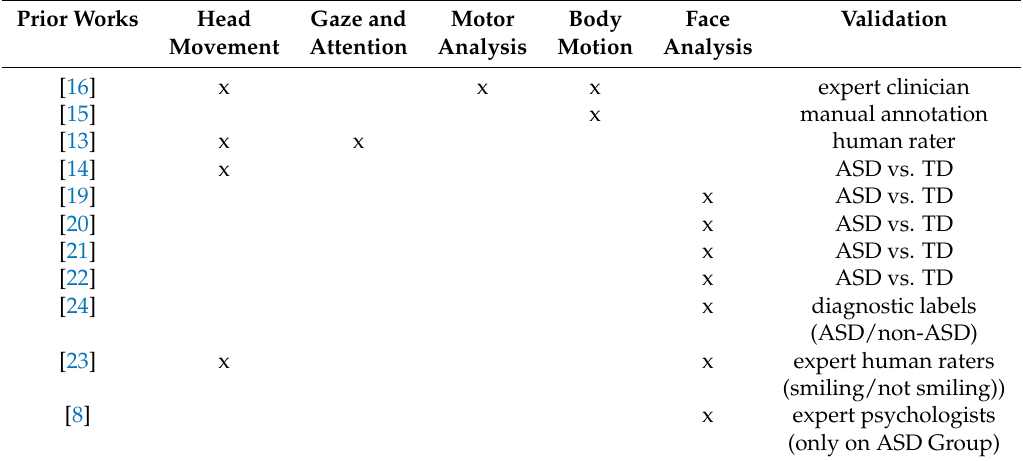
Table 1. The most relevant prior works in the literature Prior